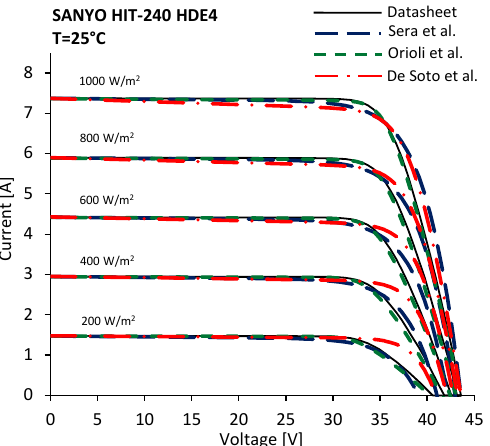
Hadj Arab et al . models.